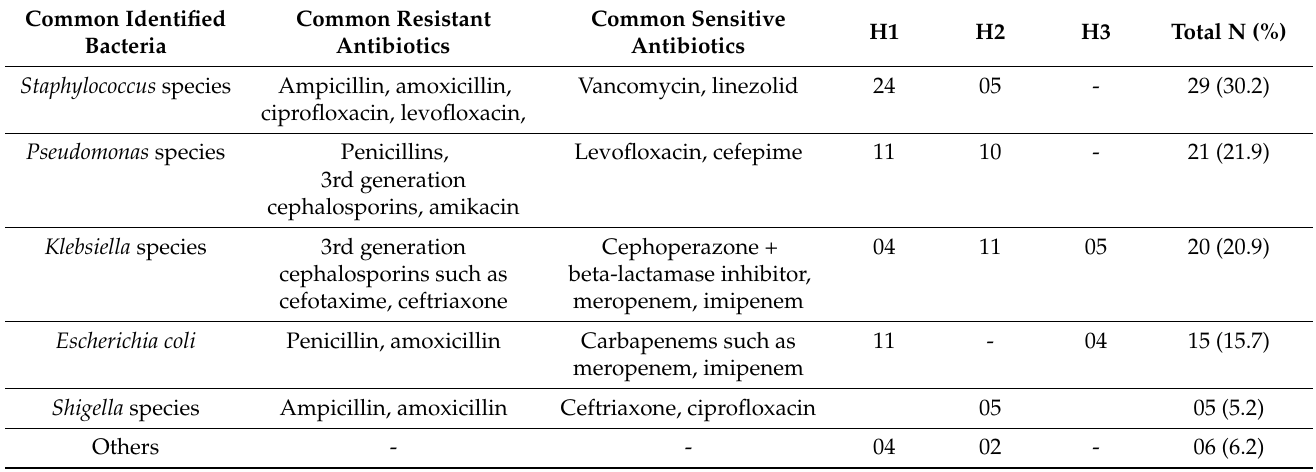
Table 3. Antibiotic resistance and antibiotic susceptibility profiles of commonly identified bacterial